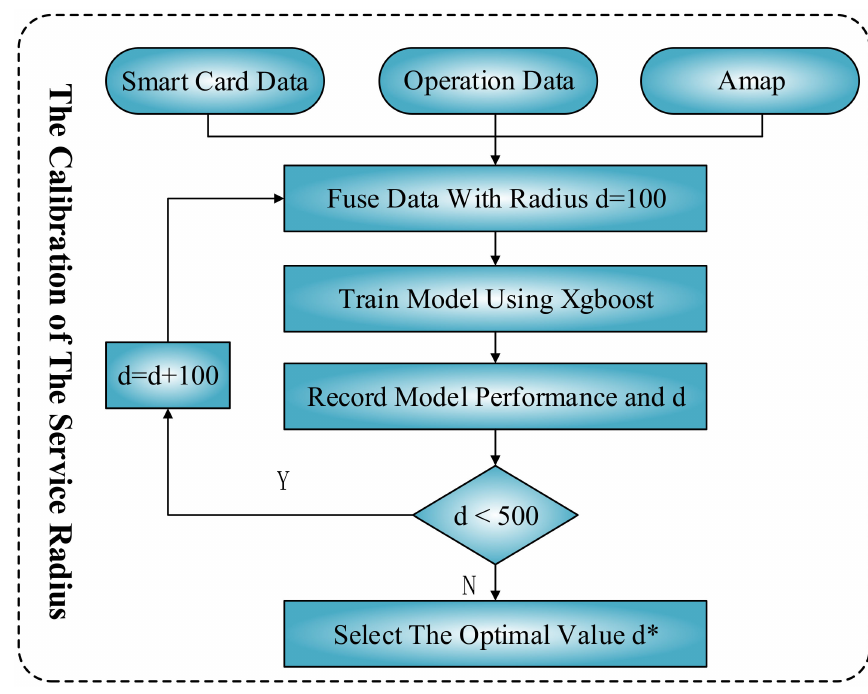
Figure 3. The process of the best service radius